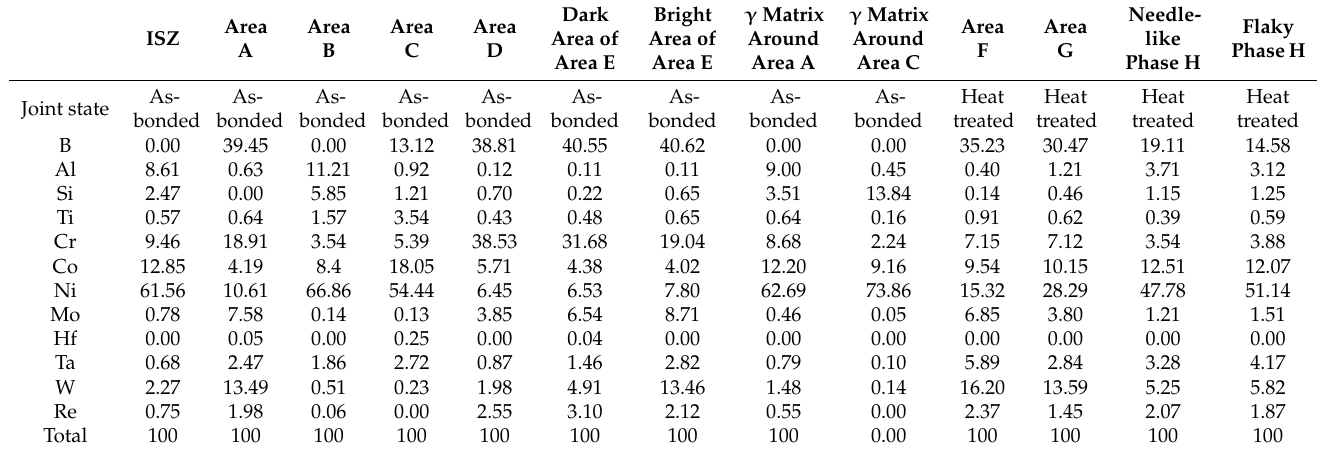
Table 2. EPMA analysis of different regions of the as-prepared and PBHT-processed joints (at.%).